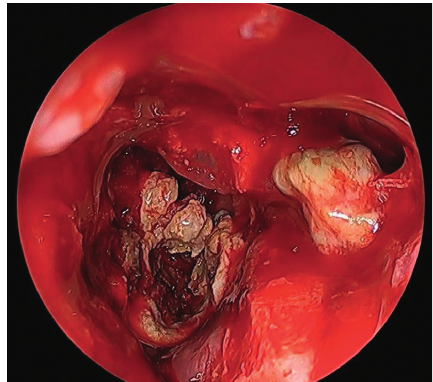
Figure 5: Coronal CT sinuses showing left sphenoid sinus fungal ball.